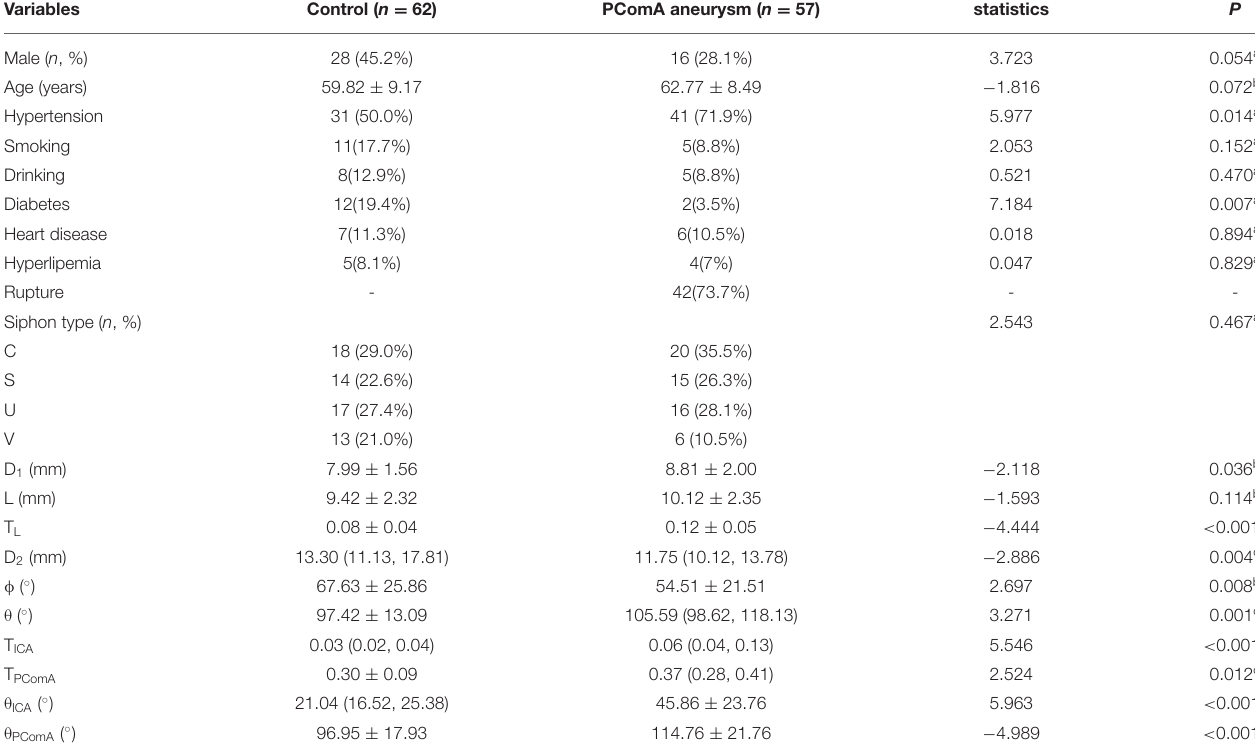
TABLE 2 | Univariate analysis of data between the control and posterior communicating artery (PComA) aneurysm groups.